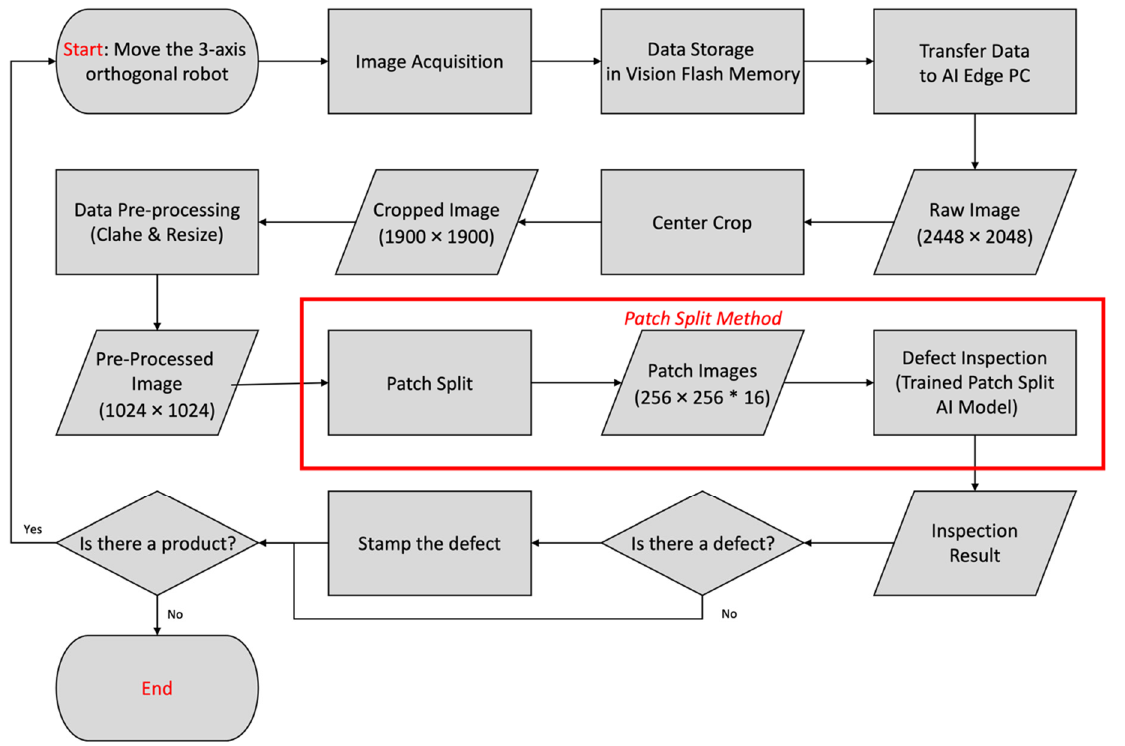
Figure 11. Proposed micro-defect detection process.